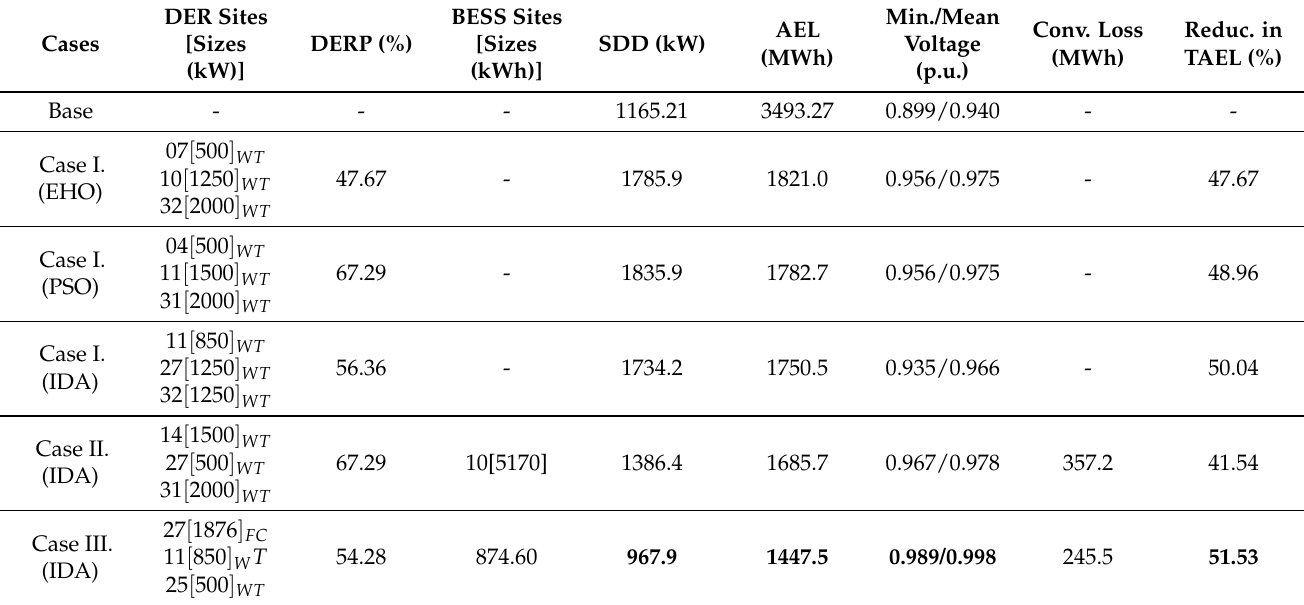
Table 5. Optimal sites and sizes of mixed DERs in 33-bus test distribution system obtained by IDA two-stage optimiza- tion method.